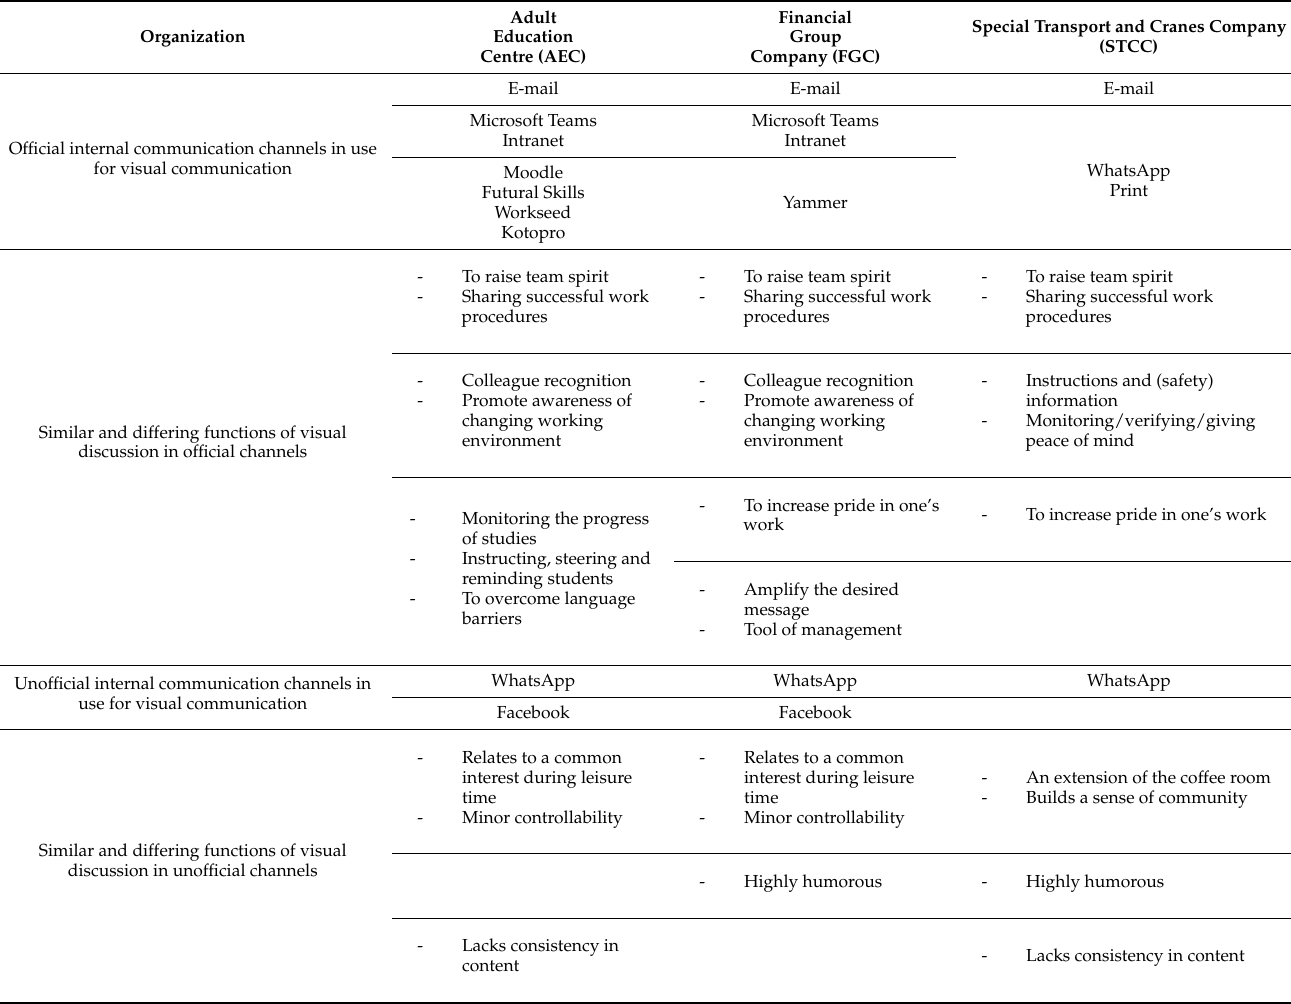
Table 1. The results obtained from the semi-structured group theme interviews and thematic